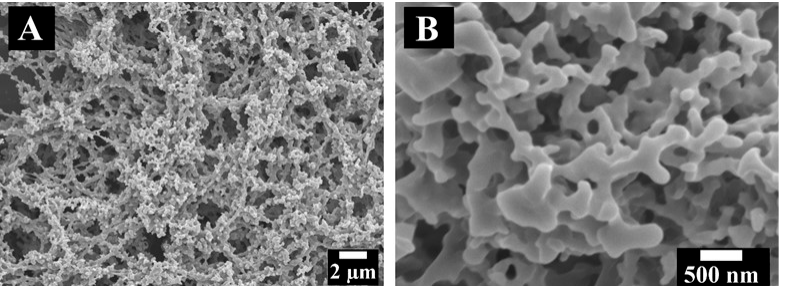
Figure 8. SEM micrographs at different magnifications of films, prepared from 10 gL − 1 PEMA with 3 gL − 1 LA and 3 gL − 1 nanocellulose. (( A ) 5000 × ),(( B ) 30,000 × ).